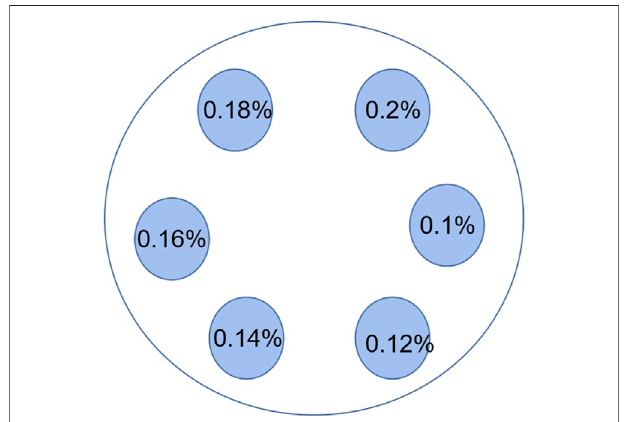
FIGURE 13 | Reconstructed images of different collimated pinholes: (A) 0.7 mm, (B) 0.8 mm, (C) 1 mm, and (D) CNR of reconstructed images under different pinholes.